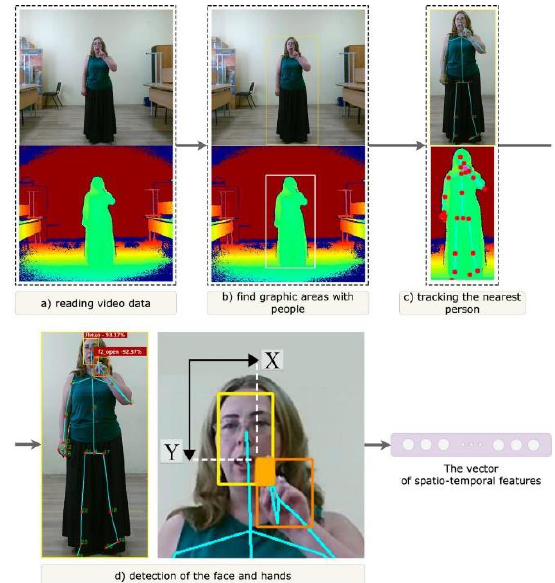
Figure 3 . Illustration of the process of extracting spatio- temporal visual signs of a